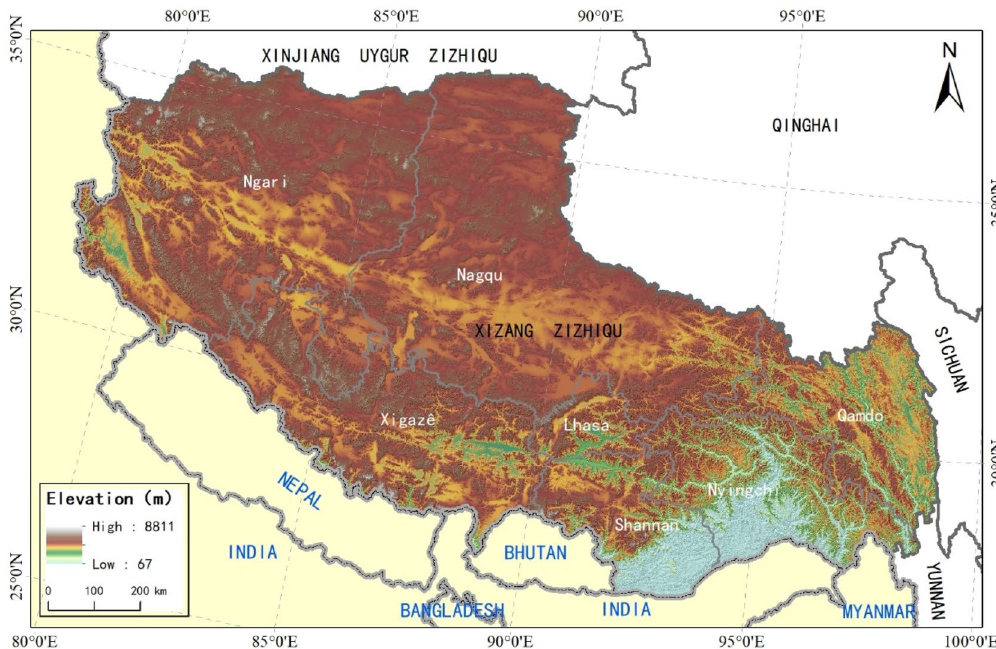
Figure 1. The geographical elevation of the study area and the location map of the surrounding countries and provinces. We created this figure in using ArcGIS 10.5 for maps (URL: http:// www. esri.